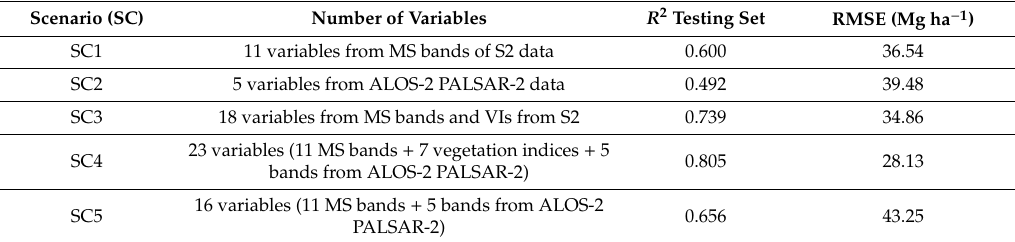
Table 7. Performance of the XGBR model using different numbers of variables. (Bold values highlight the best-performing model).